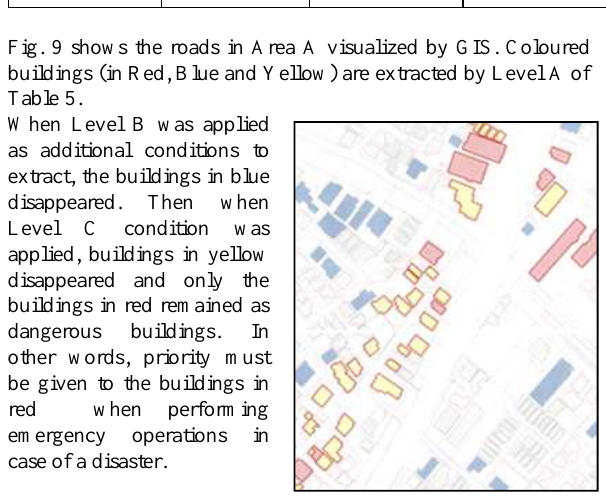
Figure.9 Extraction of buildings likely to block